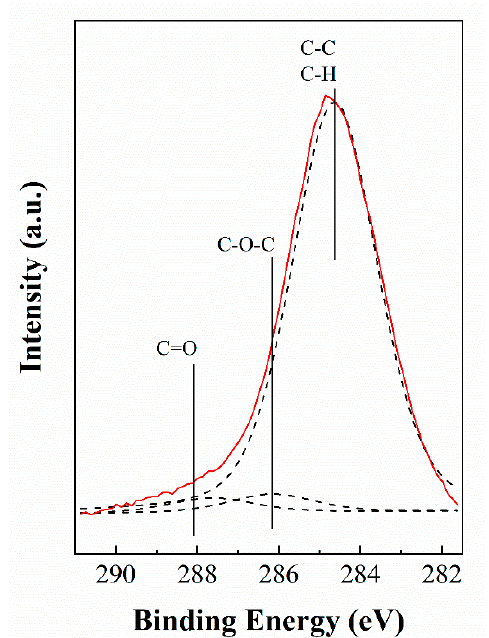
Figure 12. C 1s core level spectra for 2Pd- β catalyst, after FUR oxidative condensation reaction. Experimental conditions: temperature: 170 °C, time: 3 h, catalyst loading: 0.05 g, V (ethanol) :6 mL, amount of base (Na 2 CO 3 ): 0.10 g, V (H 2 O 2 , 30 wt%): 0.5 mL.